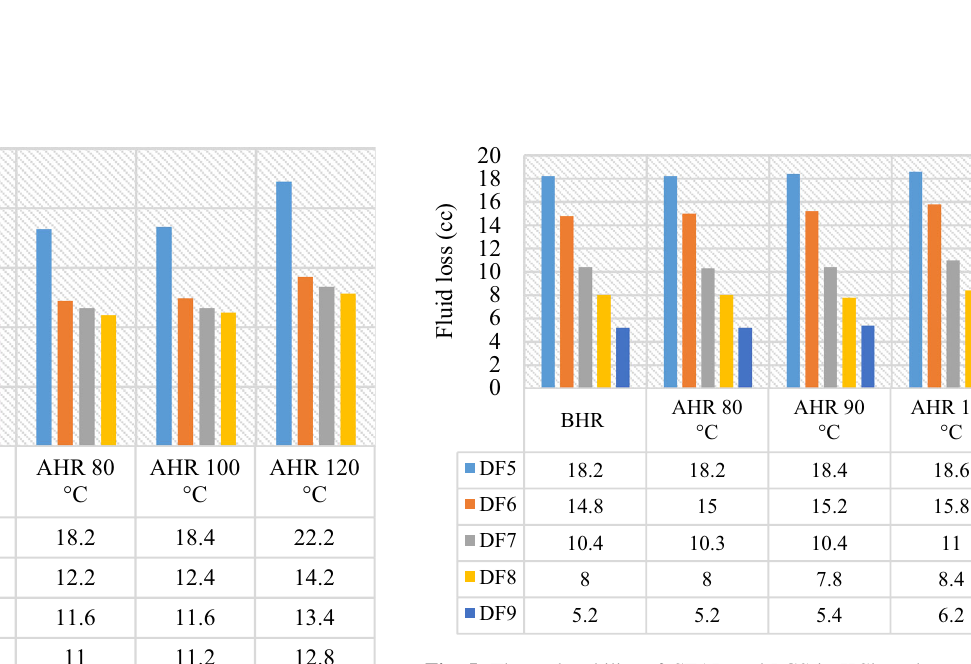
Fig. 5 Thermal stability of CTAB and PGS in KCl mud